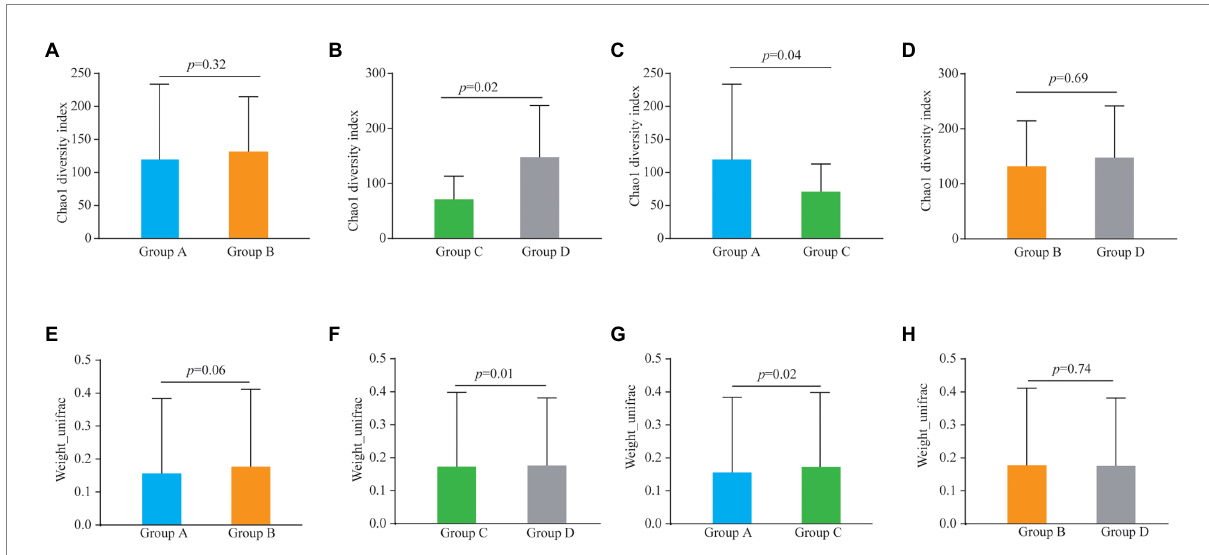
FIGURE 1 Alpha diversity analysis (Chao1 diversity index) of the bacteria from vaginal and cervical canal samples between Group A and Group B (A) , Group C and Group D (B) , Group A and Group C (C) , and Group C and Group D (D) , respectively. Beta diversity analysis of the bacteria from vaginal and cervical canal samples between Group A and Group B (E) , Group C and Group D (F) , Group A and Group C (G) , and Group C and Group D (H) ,